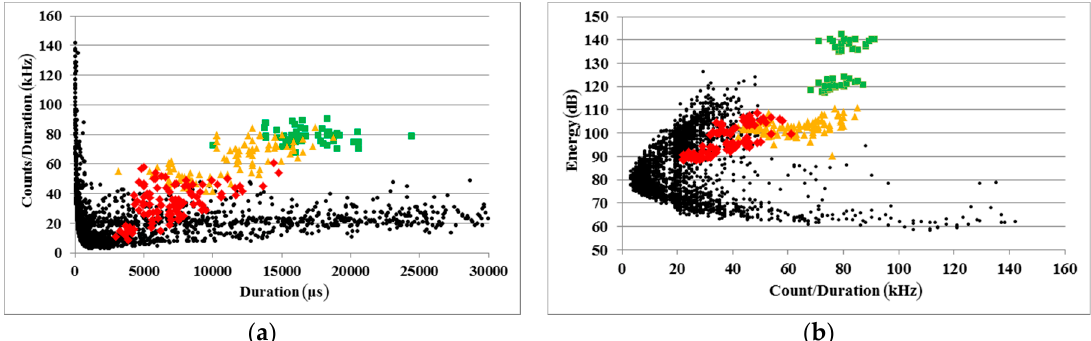
Figure 10. ( a ) Scatter plot diagram of AE signal energy and duration; ( b ) scatter plot diagram of amplitude and parameter “counts/duration.” Impulses corresponding to noise are marked black, while impulses from the Hsu-Nielsen source emitted at distances of 0–2 m, 2–7 m and 7–15 m from AE sensors are marked green, yellow and red, respectively.